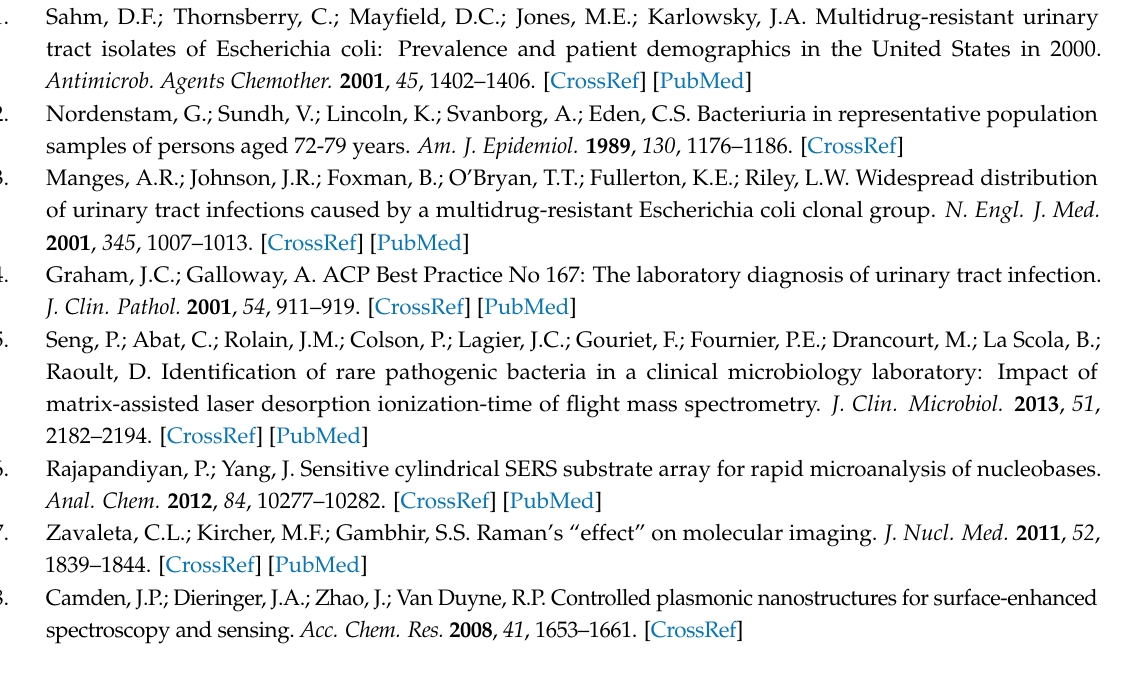
Supplementary Materials: Supplementary materials are available online. Figure S1: PCA plot of mixed bacterial